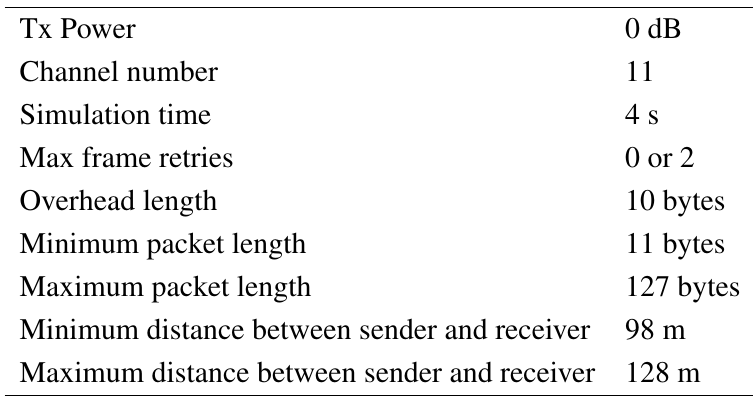
Table 2. Parameter settings in NS-3